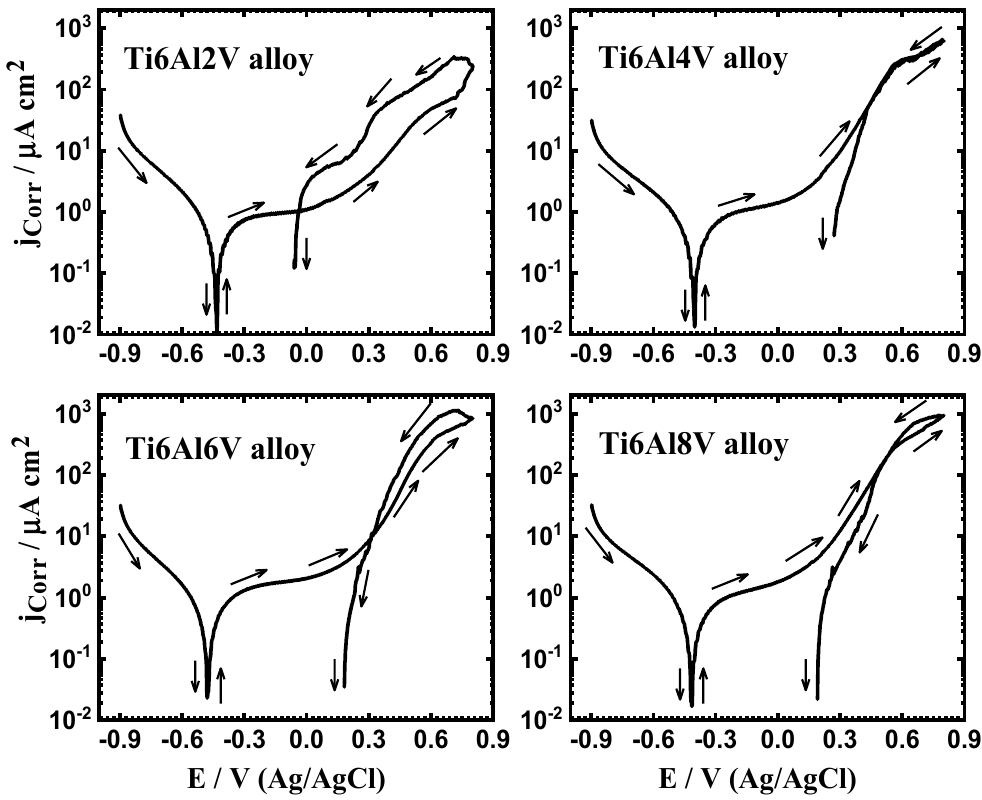
Figure 7. The CPP plots collected for TiAlV alloys after their immersion in 3.5% NaCl solution for 48